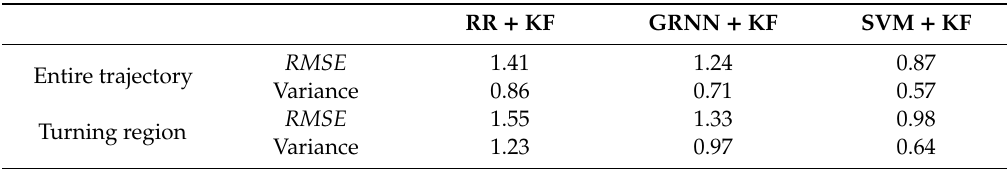
Figure 13. Error distribution of each algorithm: ( a ) ridge regression ( RR) + Kalman filter (KF); ( b ) generalized regression neural network ( GRNN) + KF; ( c ) SVM + KF. Table 8. Statistics obtained from experimental results.